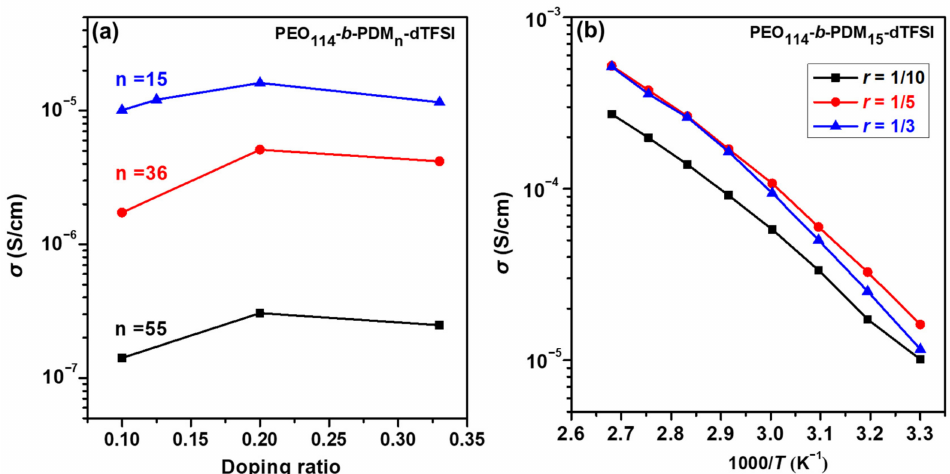
Figure 4. ( a ) Ionic conductivity of the PEO 114 - b -PDM n -dTFSI/LiTFSI hybrids at 30 ◦ C. ( b ) Temper- ature dependence of ionic conductivity of PEO 114 - b -PDM 15 -dTFSI/LiTFSI hybrids with different doping